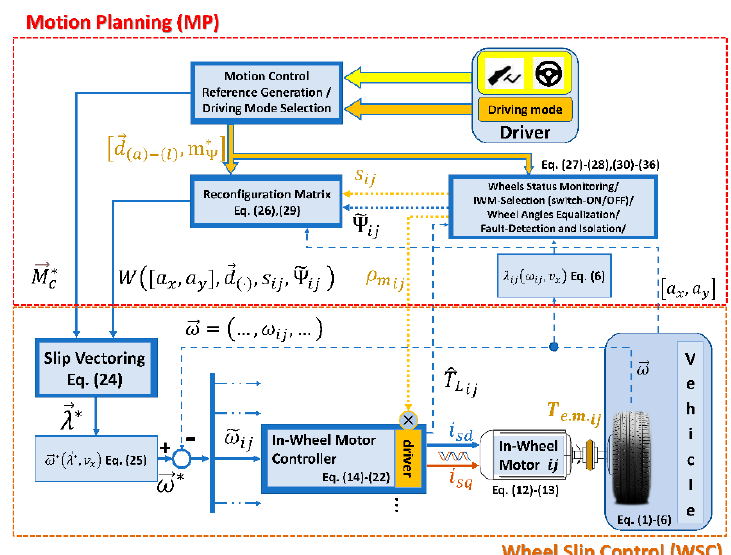
Figure 4. Reconfigurable Slip Vectoring Control Architecture.